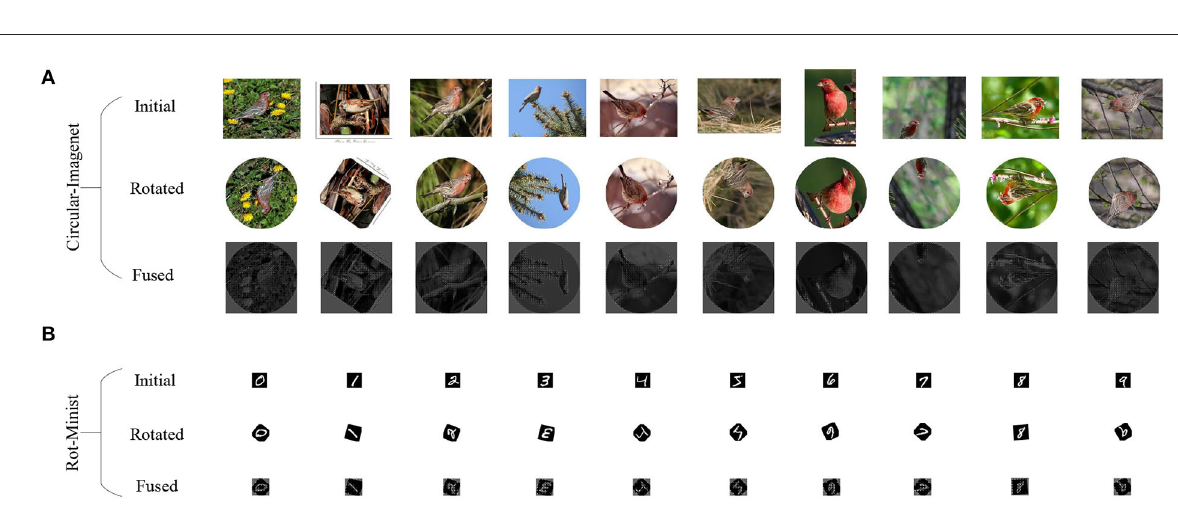
FIGURE4 The emergence of the dataset. (A) Circular-ImageNet. (B)